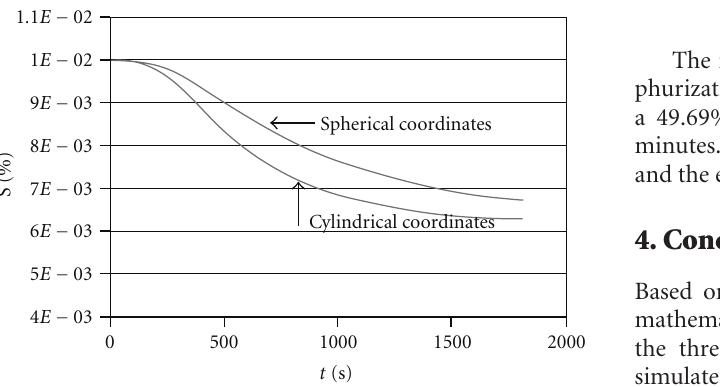
almost equilibrium at the end of injection.